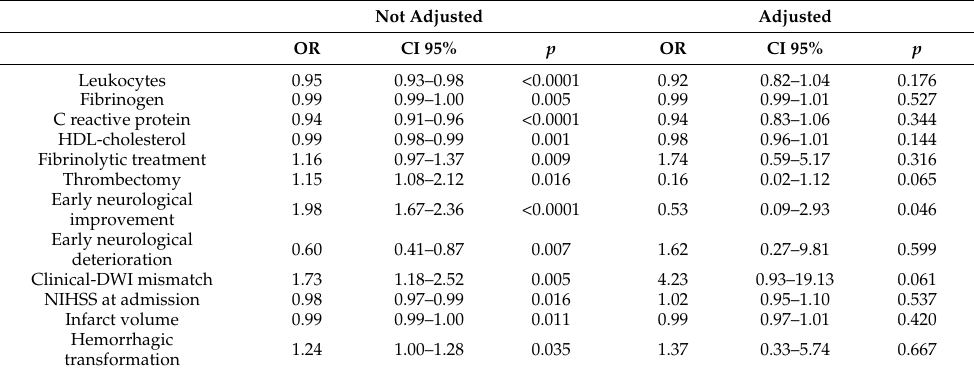
Table 3. Multivariate analysis adjusted and non-adjusted of the clinical aspects comparing Q1 with Q2, Q3 and Q4 latency